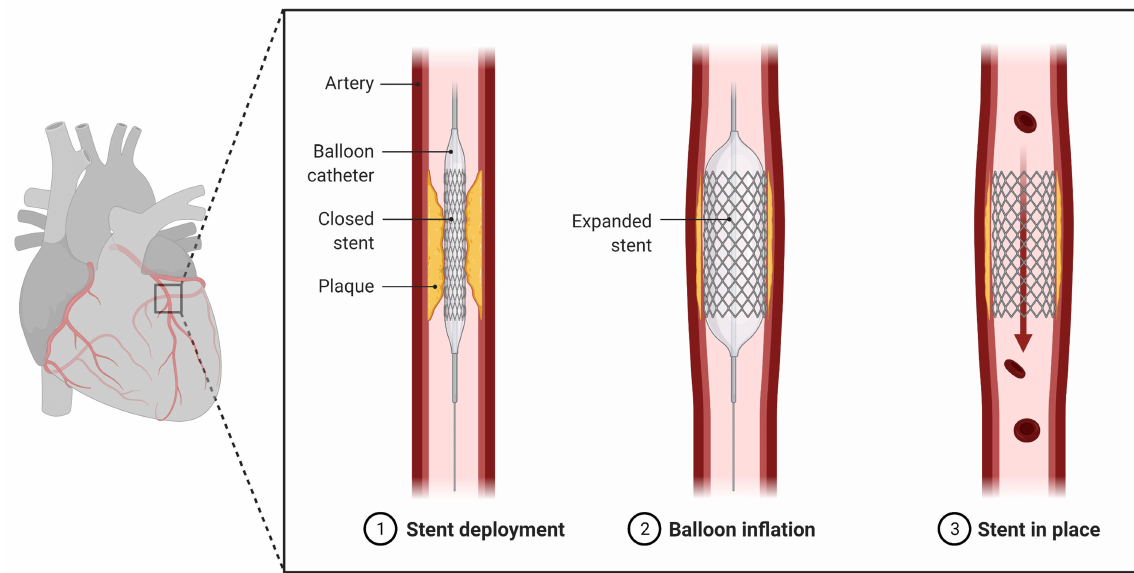
Figure 4. Percutaneous coronary intervention (PCI): PCI widens the blocked or narrow coronary arteries, thereby allowing reperfusion of the ischemic myocardium. Adapted from “Percutaneous Coronary Intervention”, by BioRender.com (2021). Retrieved from https://app.biorender.com/biorender-templates on 11 August